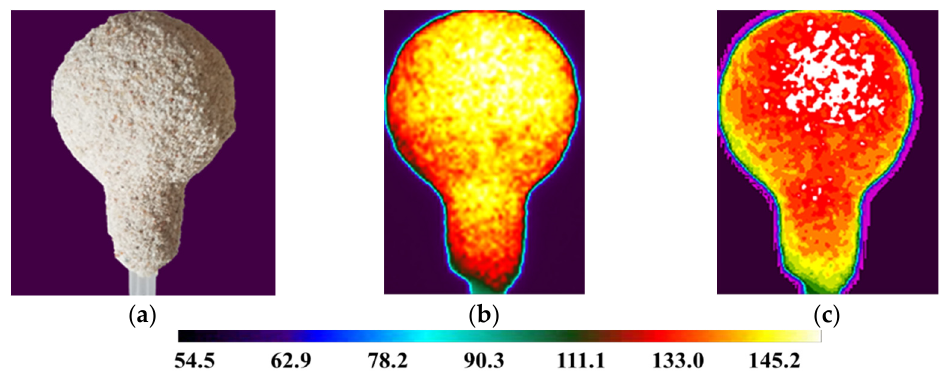
Figure 13. M3 sample ( a ); sample thermogram M3 obtained directly from the camera ( b ); defecto- gram of M3 sample with a temperature map scale ( c ).